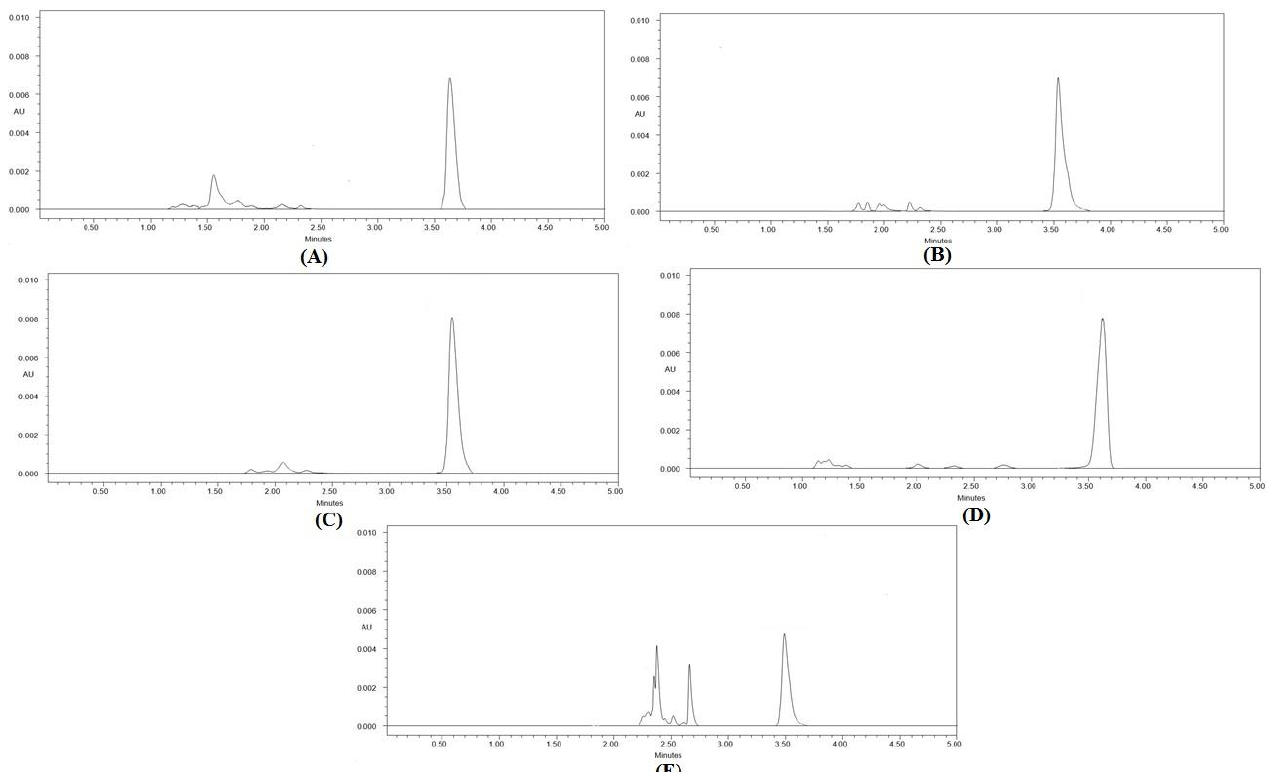
Figure 3. Greener HPLC chromatograms of CCM recorded under ( A ) acid-induced degradation, ( B ) base-induced degradation, ( C ) oxidative degradation, ( D ) thermal degradation, and ( E ) photolytic degradation of CCM.